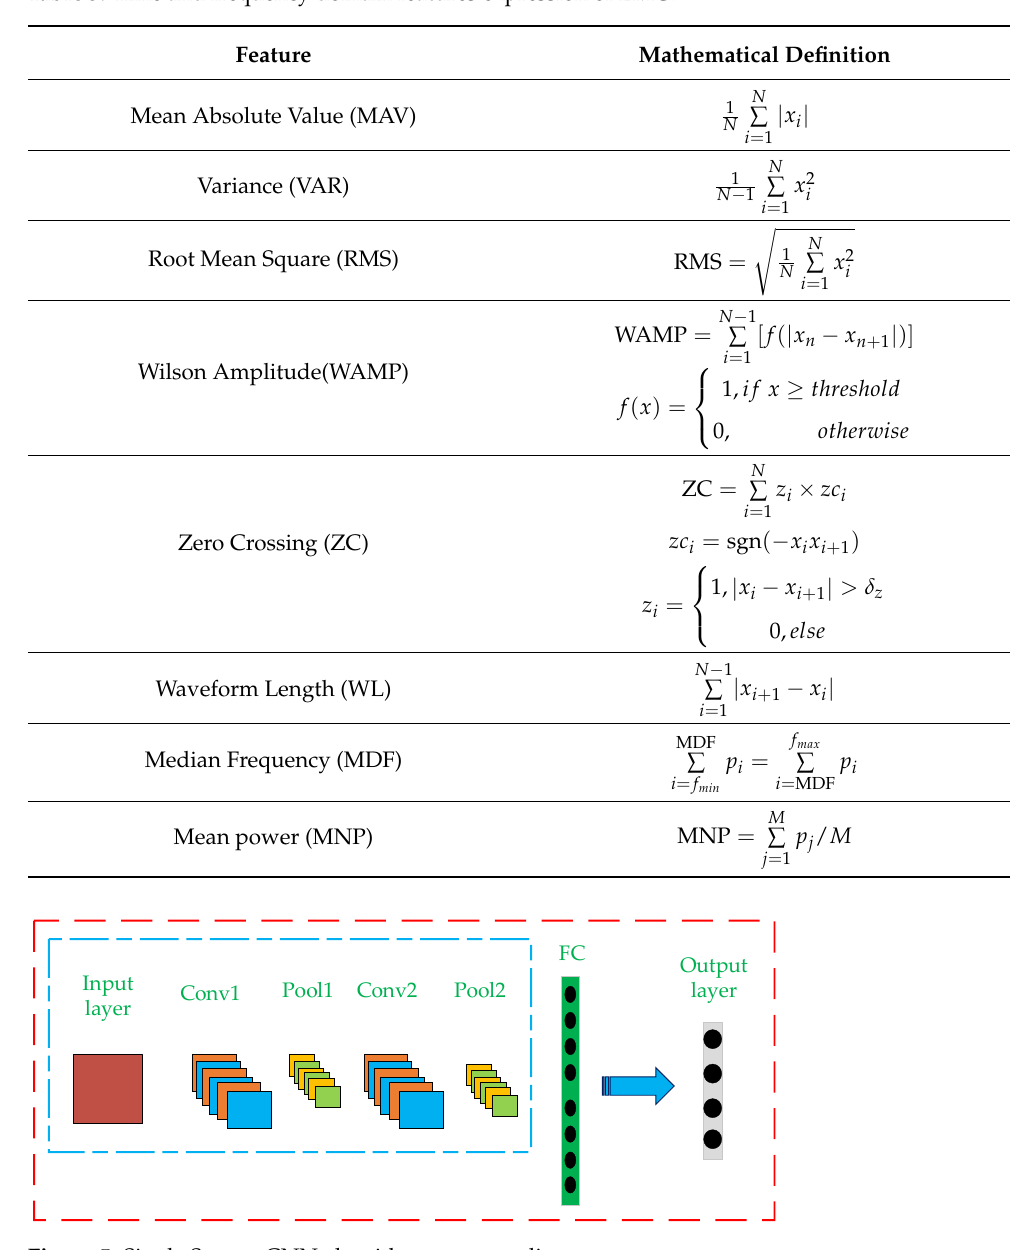
Figure 5. Single Stream CNN algorithm structure diagram.